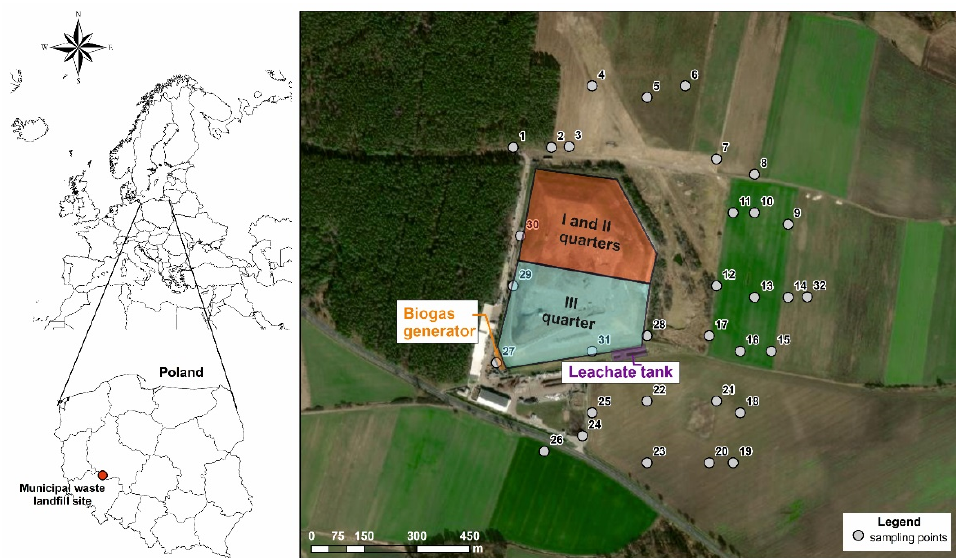
Figure 1. Location of the municipal waste landfill site (51°38 ′ 03.3 ″ N 16°41 ′ 56.8 ″ E) and 32 atmospheric air sampling points on 22 August 2017. Base map source [52].